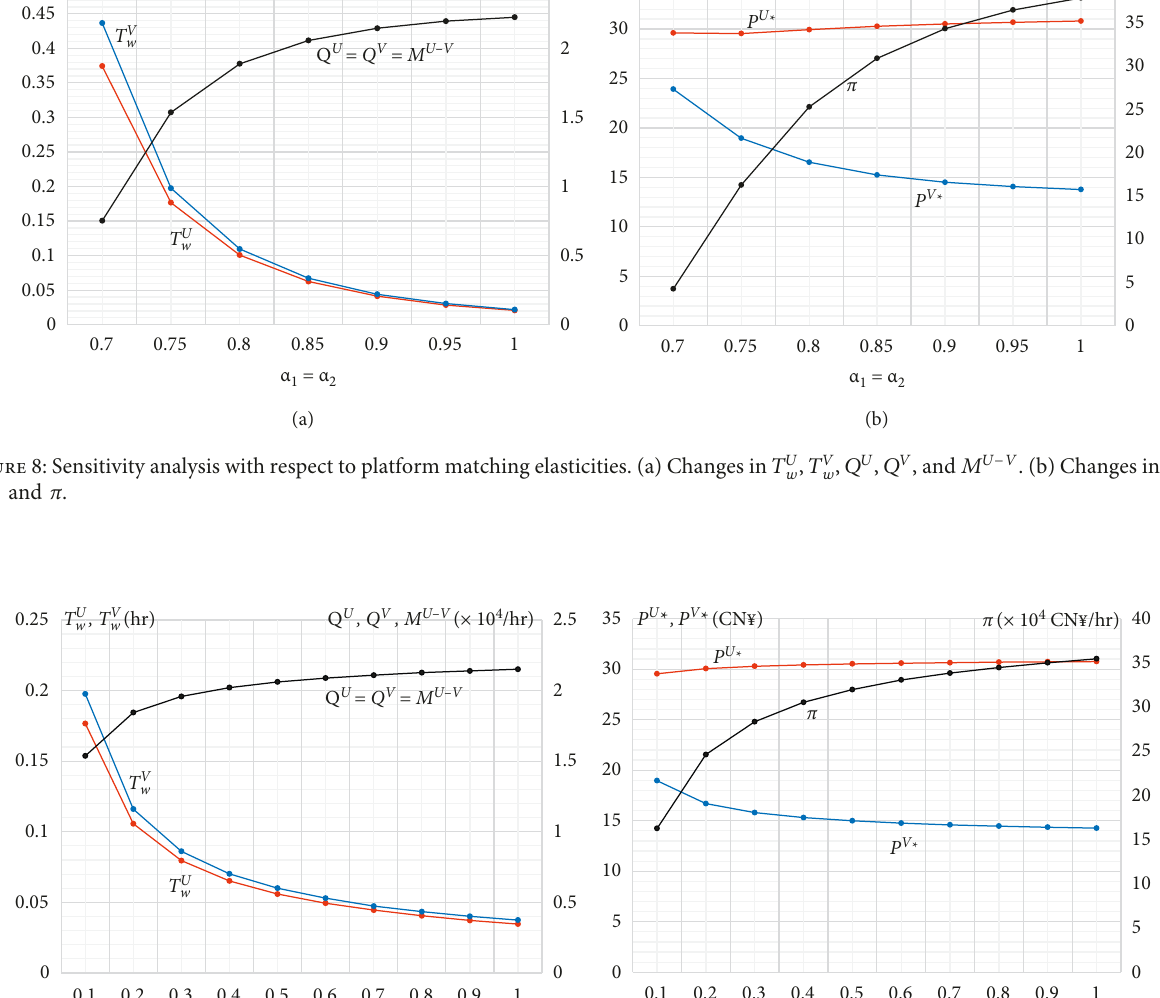
T V Q U , Q V , and M U − V . (b) Changes in P U ∗ , P V ∗ , w , w ,